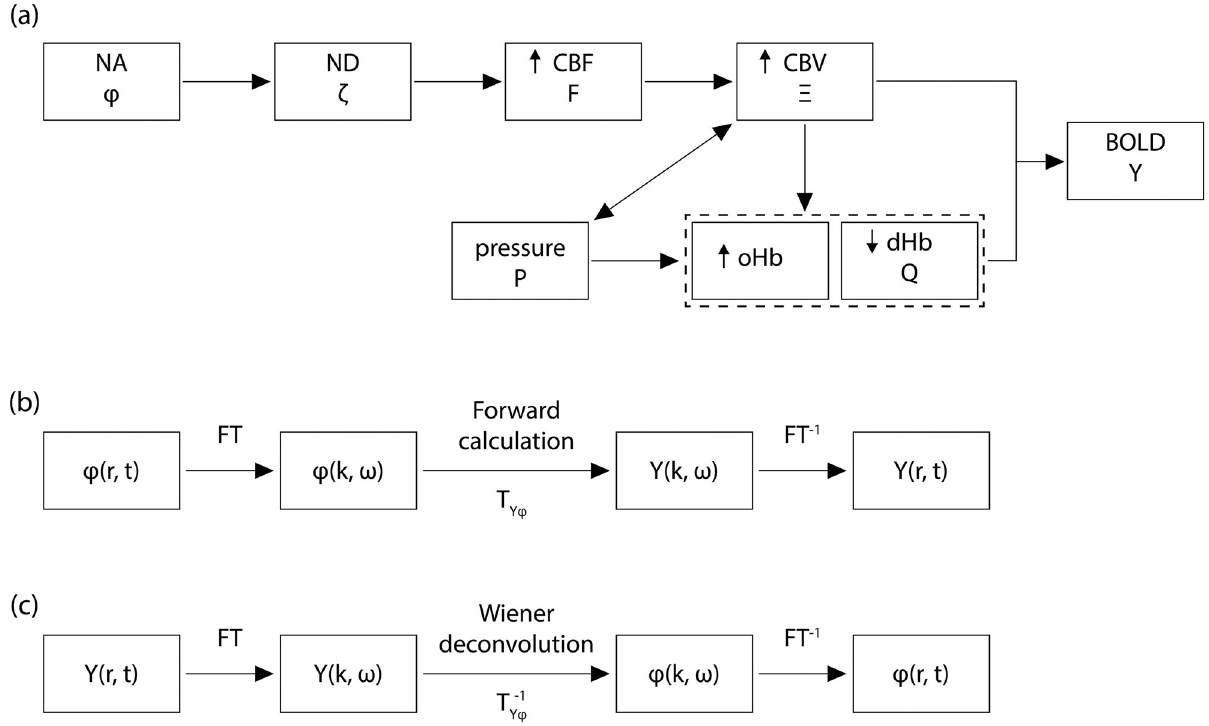
Fig 4. Flowcharts describing the stHRF physical processes in the model and the deconvolution method. (a) Estimation of the BOLD response from a neural activity (NA), including the intermediary physiological processes. The enclosed dashed box in oHb and dHb denotes that they are almost simultaneously affected by the other processes. ND denotes neuroglial drive. (b) Summary of the mathematical formulation for the BOLD estimation from NA. (c) Summary of the mathematical formulation to recover the NA from BOLD. For panels b and c, T is the transfer function and T − 1 is its inverse, while FT denotes the Fourier transform and FT − 1 denotes its